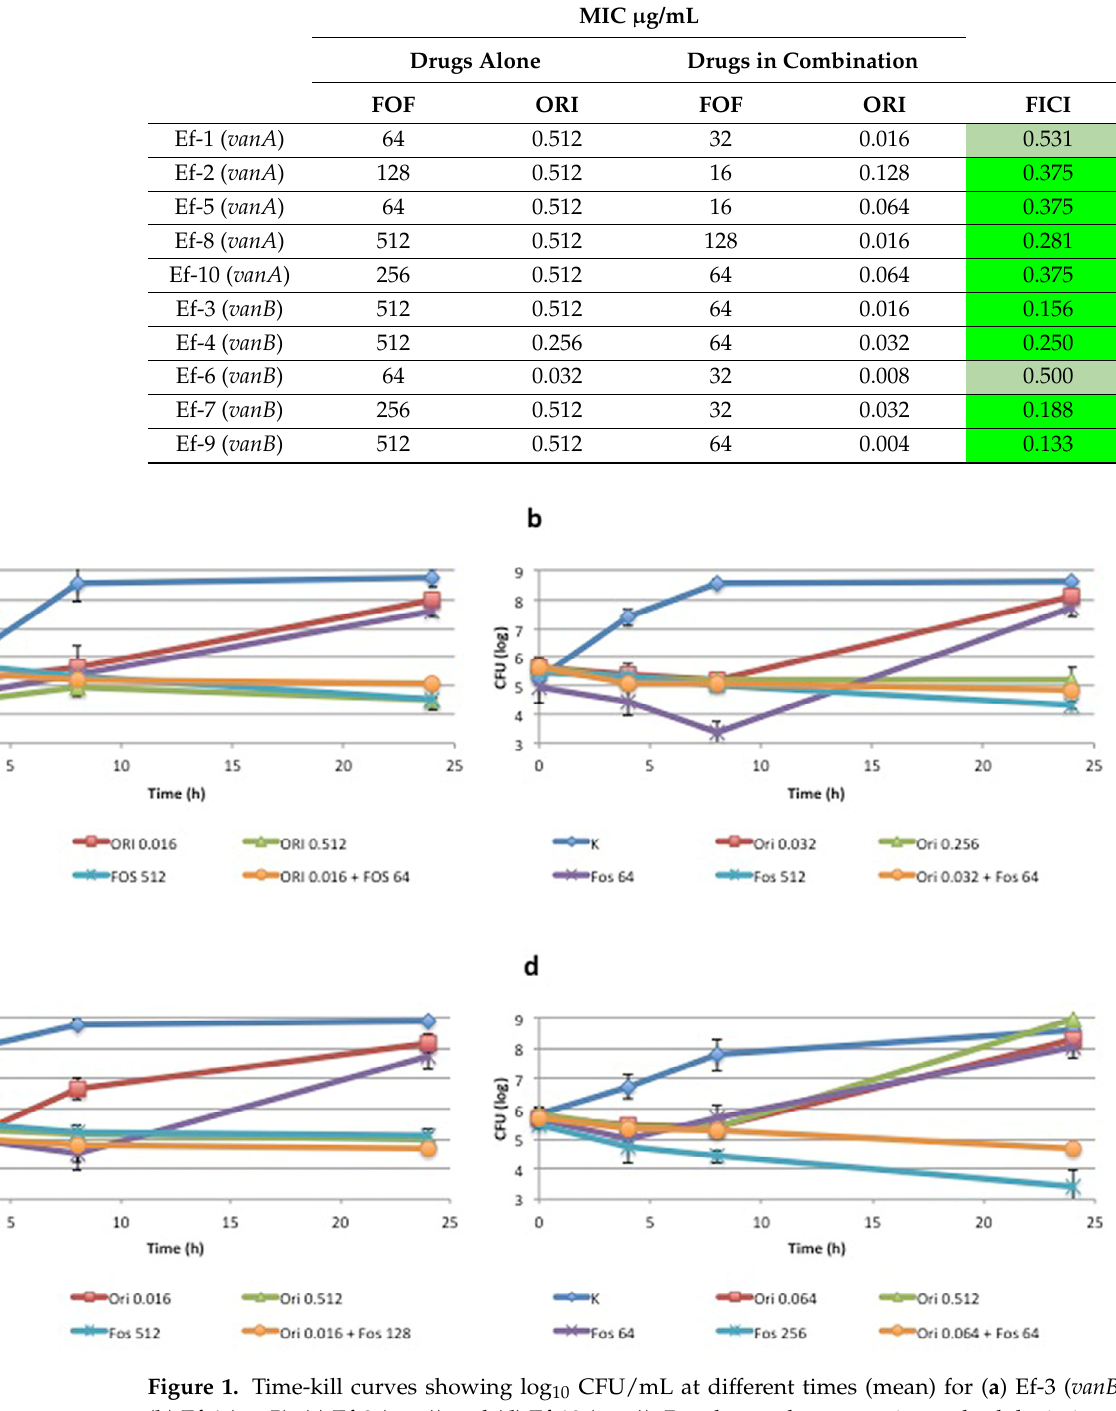
Table 1. MIC values of fosfomycin (FOF) and oritavancin (ORI), alone and in combination, obtained by checkerboard assay, and the resulting FICI values (light green: synergistic effect; dark green: additive effect). Mode values of two independent experiments, carried out in triplicate, are reported.